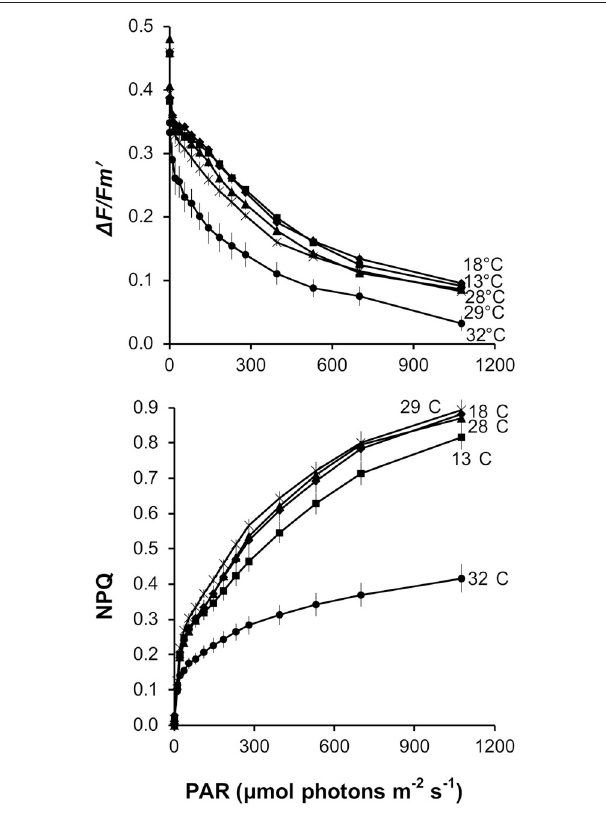
FIGURE 3 | Balanophyllia europaea . Rapid light curves indicating 1 F/F m ′ (396) and non-photochemical quenching (NPQ) for each irradiance step at the five temperature treatments (13 ◦ C, squares; 18 ◦ C, diamonds; 28 ◦ C, triangles; 29 ◦ C, asterisks; 32 ◦ C, circles). Error bars are standard errors.